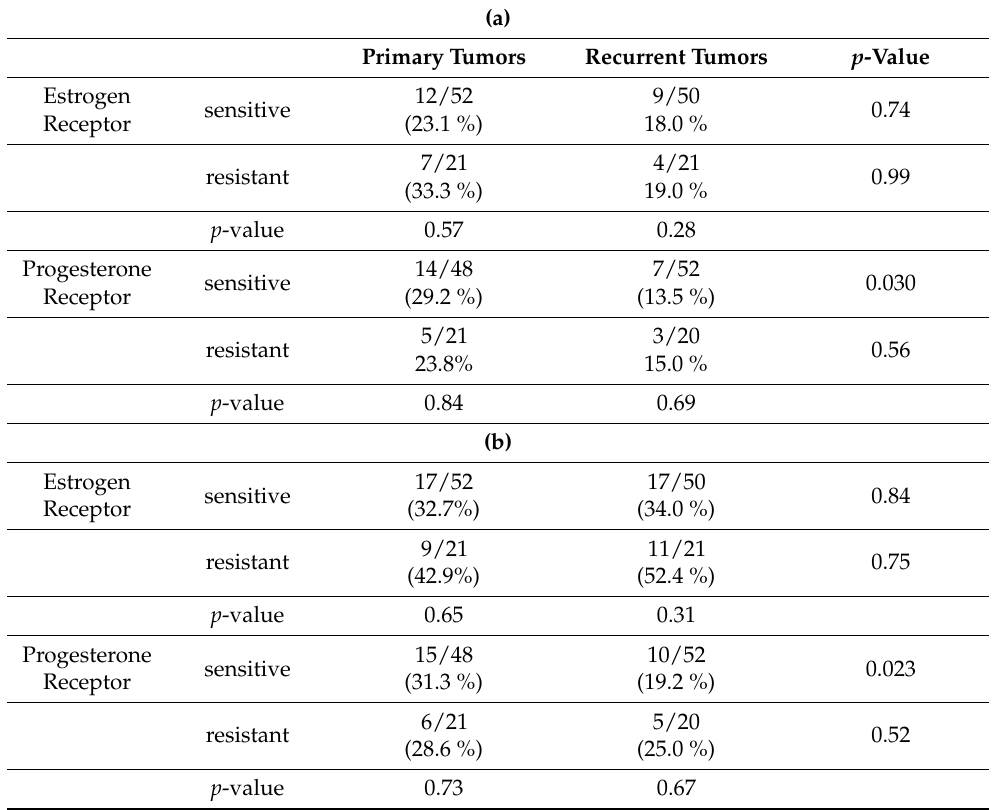
Table 2a shows the association of estrogen and progesterone receptor immunoexpressions (Immunoreactive scoring systems) of primary and recurrent tumors and in chemotherapy (platinum-based)-sensitive and -resistant cases. p -values of independent data are based on unpaired Wilcoxon tests on original scores. p -values of dependent data are based on paired Wilcoxon tests on original scores. Table 2b shows the association of